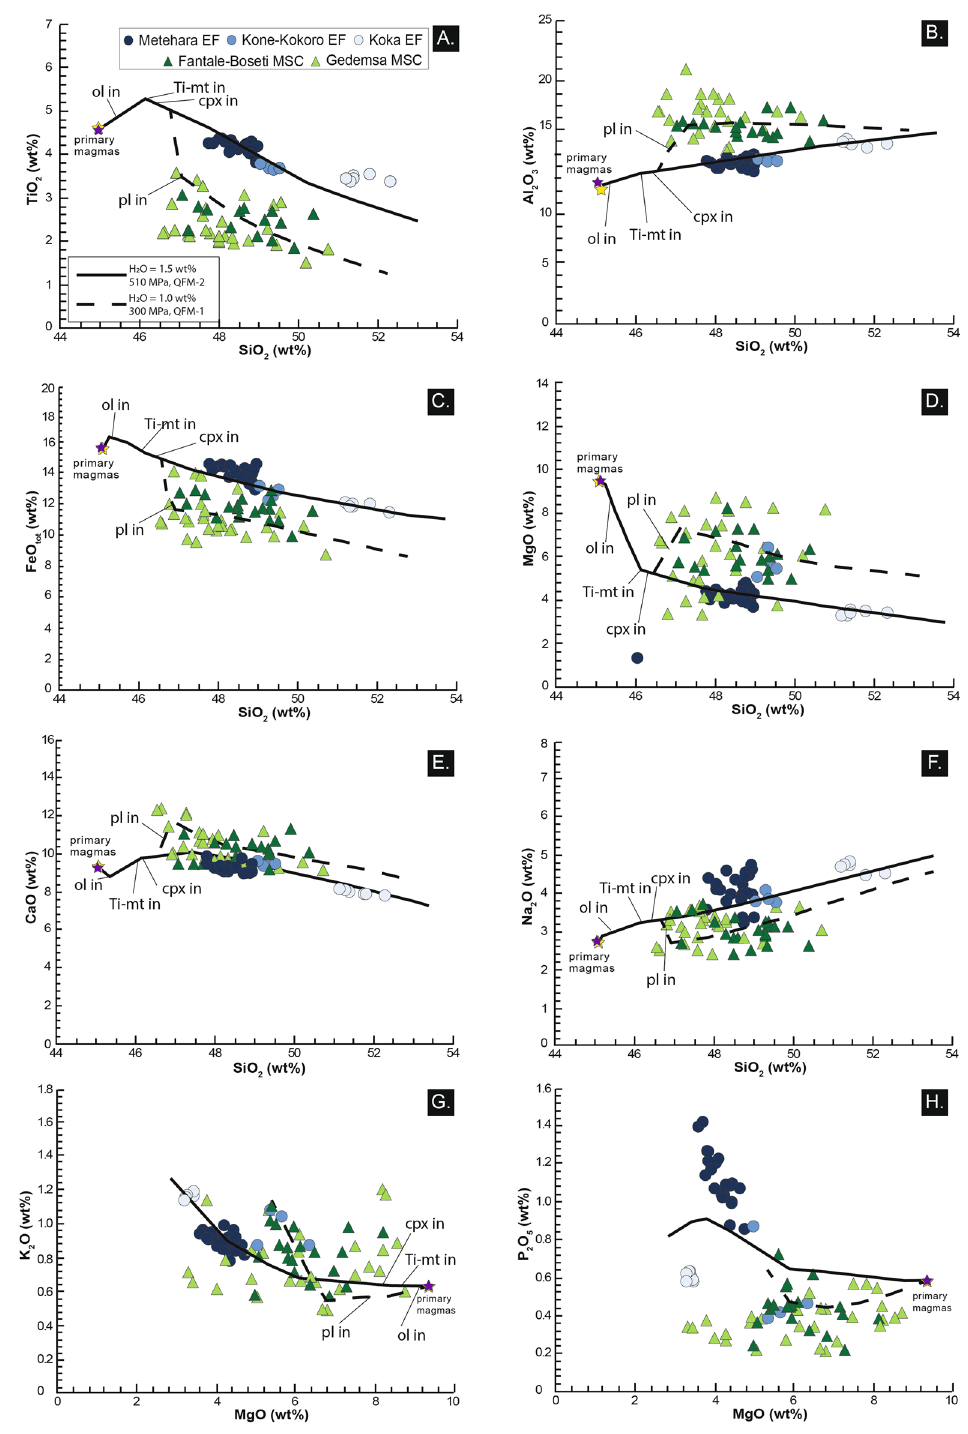
Figure 5. Whole rock compositions for major elements of analysed products. Samples labelled “Gedemsa MSC” are taken from 41 . SiO 2 and MgO vs. major elements variation diagrams for the analysed products (compositions in ESM 2). EF products show a peculiar high-TiO 2 –FeO tot –Na 2 O–P 2 O 5 signature (A,C,F,H) . The yellow and black stars represent the parental (and primary) magma composition for both EF and MSC products calculated by means of the PRIMELT3 software 62 . Liquid lines of descent obtained from Rhyolite-MELTS crystal fractionation simulations 47 are also shown; solid and dotted lines represent two different conditions of crystallization, respectively at: (I) temperature between the eutectic temperature of 1331 °C (obtained by Rhyolite-MELTS, in accordance with the interval 1300–1350 °C found by 65,66 ) and 1000 °C; H 2 O = 1.5 wt.%, 510 MPa, QFM-2 and (II) T = 1151–1000 °C; H 2 O = 1 wt.%, 300 MPa, QFM-1. MSC products, although with less homogeneous compositions, underwent two processes of crystal fractionation at different pressures before to be